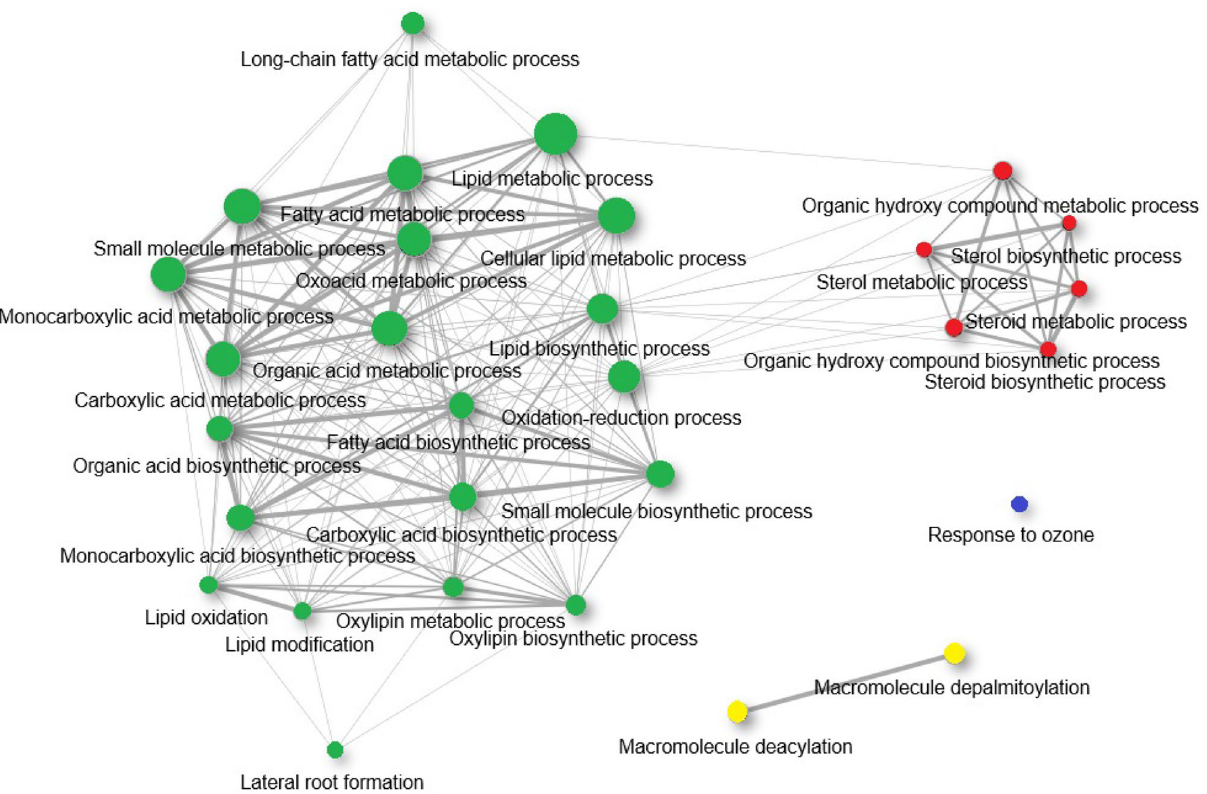
Figure 5. Interaction networks of milk thistle lipids pathways. Each node corresponds to a lipid pathway and the lines between them represent the interaction between them. The identical colors of the nodes indicate the proximity of the respective pathways. These colors correlate with the color of the nodes in the gene network, so that the genes of each color play a role in the lipid pathways of the same